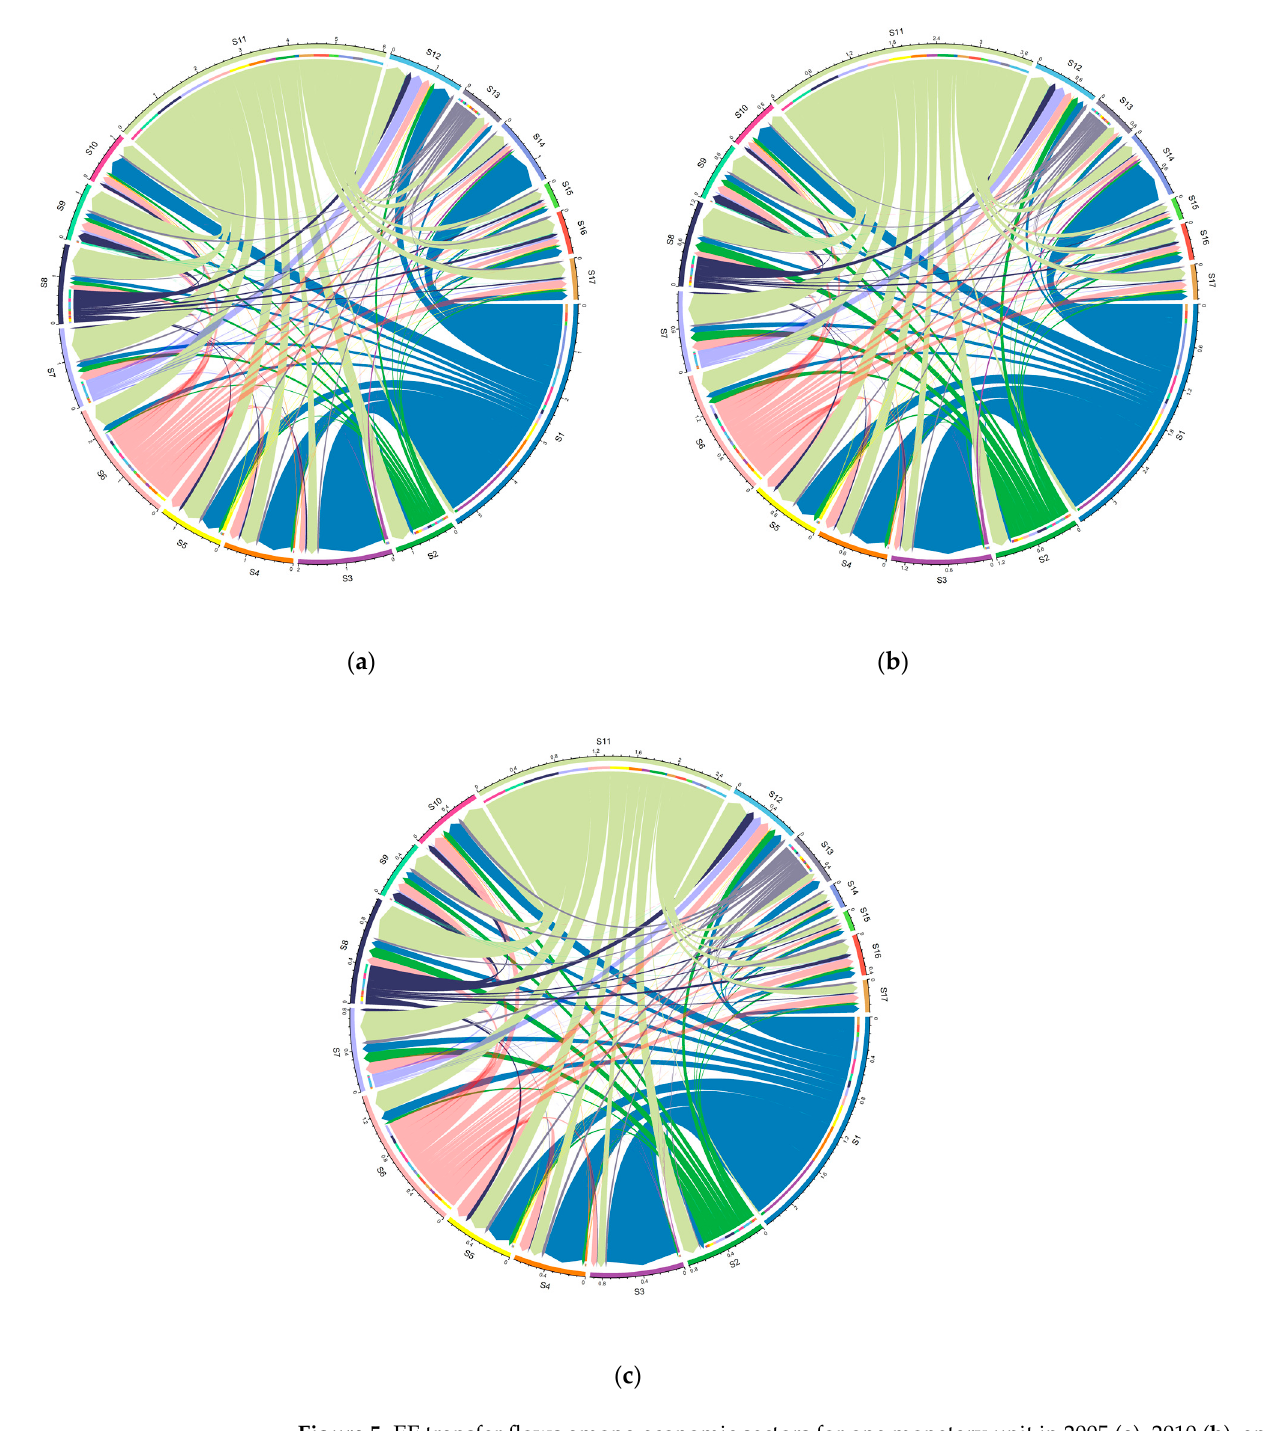
Figure 5. EF transfer flows among economic sectors for one monetary unit in 2005 ( a ), 2010 ( b ), and 2015 ( c ).